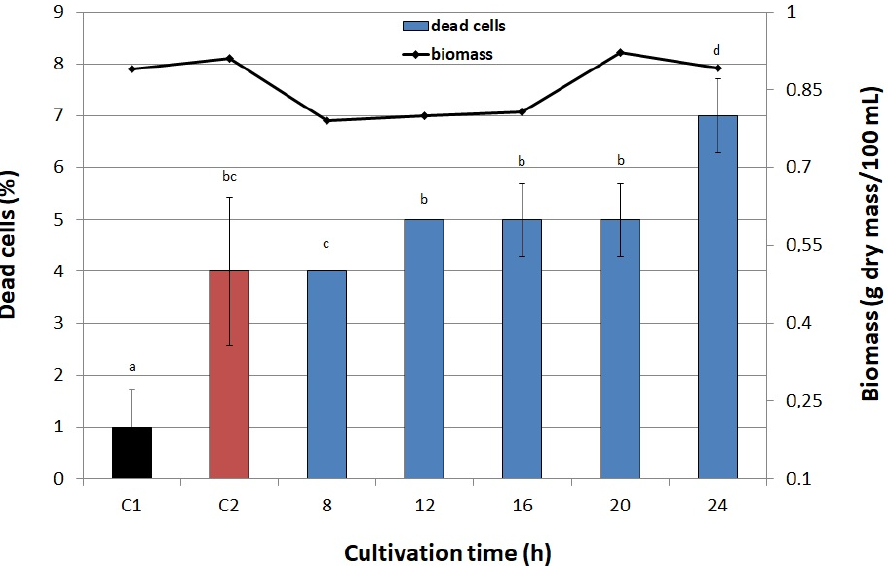
Figure 6. Effect of cultivation time after which PEF was applied on viability of cells and biomass. C1—control culture without iron ions added to the medium and PEF treatment, C2—control culture with iron ions added to the medium (200 µ g/mL) and without PEF treatment, blue bars—cultures treated with PEF (ferric nitrate, 200 µ g Fe 3+ /mL, voltage 1500 V, pulse width 10 µ s, treatment time 20 min, 1200 pulses). Each value is the mean ± standard deviation ( n = 3). Bars with the same letter (a–d) are not significantly different ( p < 0.05).